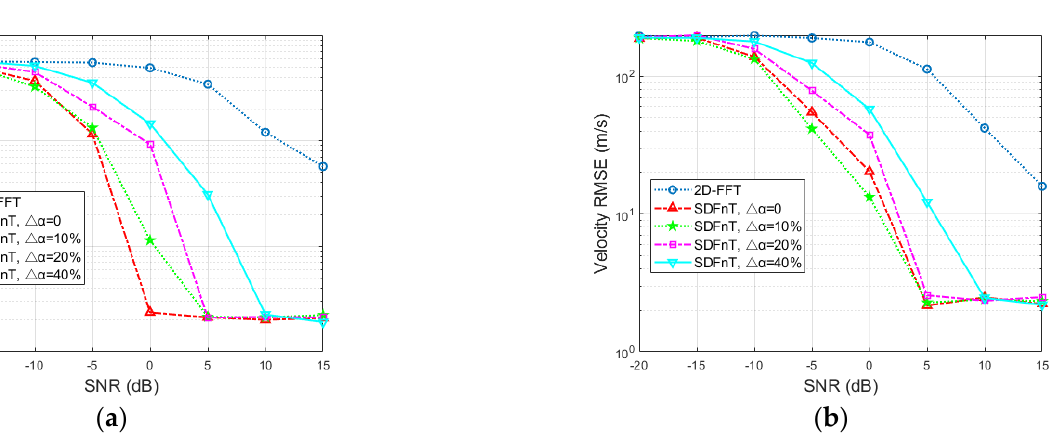
Figure 8. Clustered multi-target results in terms of SNR ( a ) RMSE for the range estimation ( b ) RMSE for the velocity estimation.